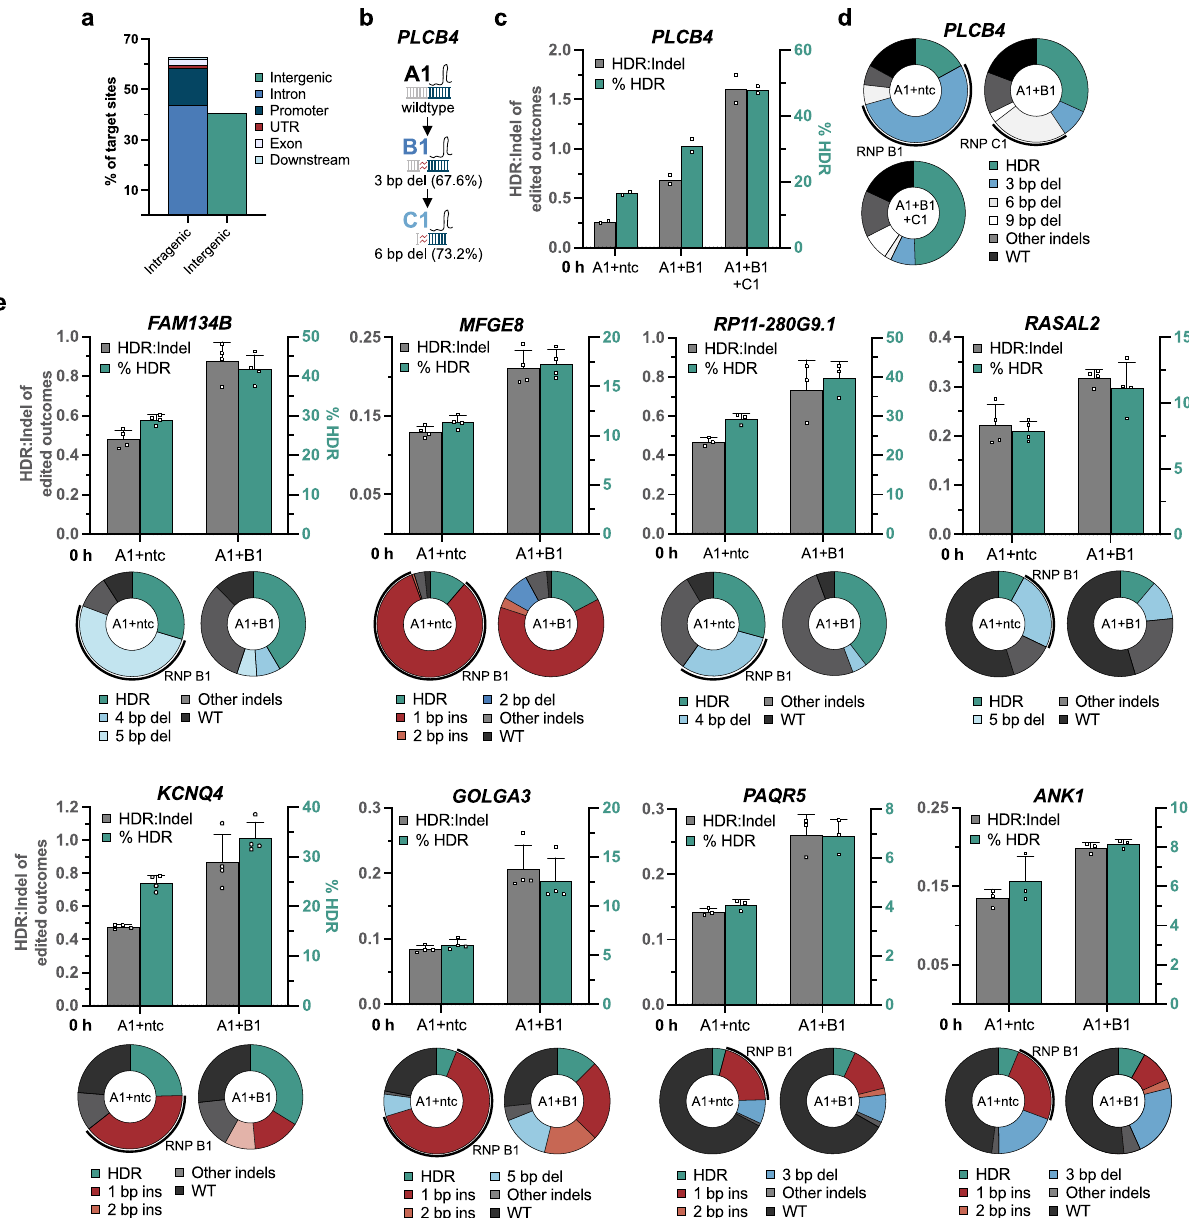
Fig. 2 HDR improvement by Recursive Editing is effective at diverse target sites. a Genomic location of target sites generated by a genome-wide search with REtarget. Downstream is de fi ned as <3 kb away from a gene. b REtarget output for a locus in PLCB4 . Lindel-predicted abundances for each round of editing are displayed next to the predicted outcome. c Recursive Editing at PLCB4 in HEK-293T cells with the indicated gRNAs, displayed as HDR:indel ratio on the left y-axis and the corresponding HDR frequency on the right y-axis. d Individual editing outcomes from c . e Two-level Recursive Editing outcomes at the indicated locus in HEK-293T cells. The individual editing outcomes are displayed as pie charts below for each locus. The percentage of alleles targeted by RNP B1 are indicated by the outer curve. Each data point represents an individual biological replicate ( n = 2 – 4). Axes are scaled for each individual graph. Error bars + / − standard deviation (SD). Abbreviations: ins insertion, del deletion, ntc nontargeting control, indels insertions and deletions, WT wildtype. Source data are provided as a Source Data fi